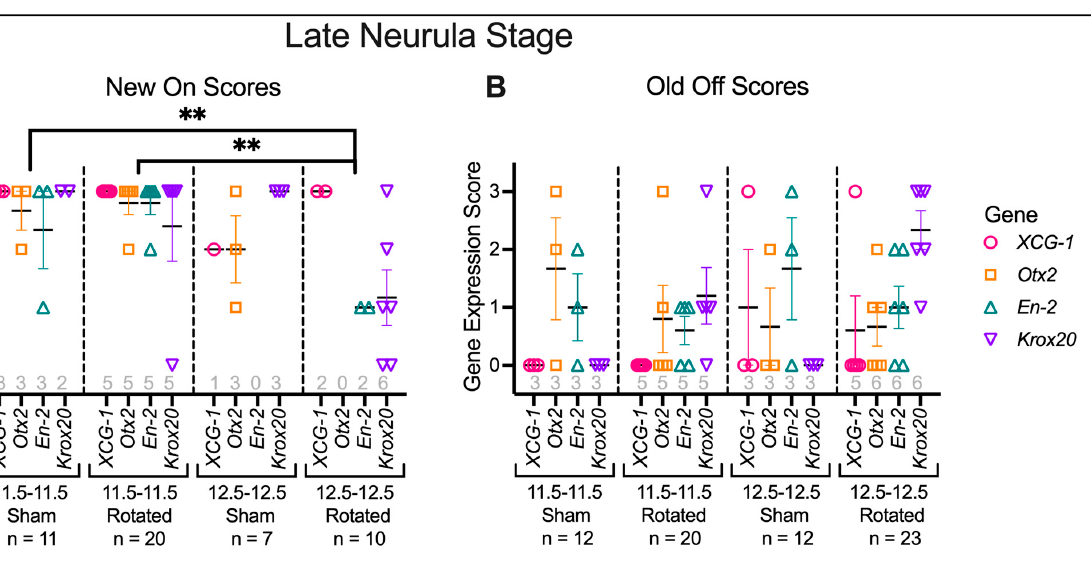
Figure 6. Representative histology for transplants at late neurula stage with sibling control comparisons. Dorsal is facing up. The four regional marker genes XCG-1 , Otx2 , En-2 , and Krox20 are expressed at the cement gland, eye and forebrain, midbrain, and rhombomeres 3 and 5 of the hindbrain, respectively. Purple stain marked with a solid arrowhead indicates gene expression colocalized with transplant tissue, purple stain marked with an empty arrowhead indicates endogenous gene expression, and blue stain indicates transplant incorporation. Late gastrula rotated embryos show decreased level and more restricted area of marker gene expression at correct locations compared with mid-gastrula sham and rotated embryos. Scale bar represents 250 µ m.